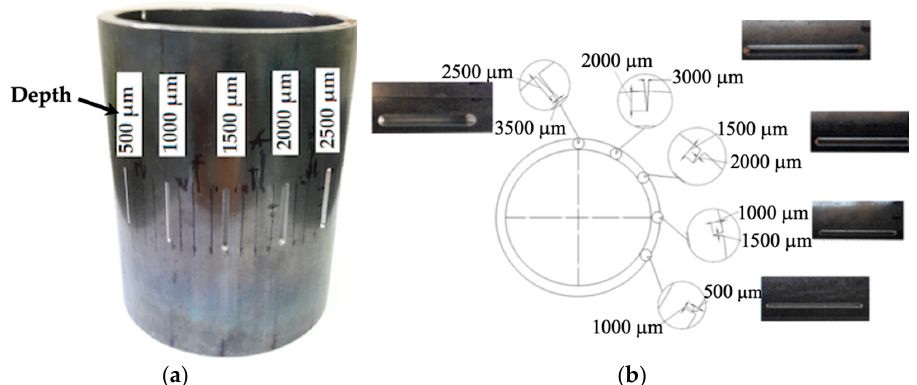
Figure 1. Five V-shaped notches ( a ) of different widths and depths (1000 µm × 500 µm, 1500 µm × Figure 1. 1000 µm, 2000 µm × 1500 µm, 3000 µm × 2000 µm, and 3500 µm × 2500 µm) on the outer surface Table 1. Dimensions of five V-shaped notches on the surface of an ASTM-A36 steel pipe. and ( b ) along the perimeter of an ASTM-A36 steel pipe.